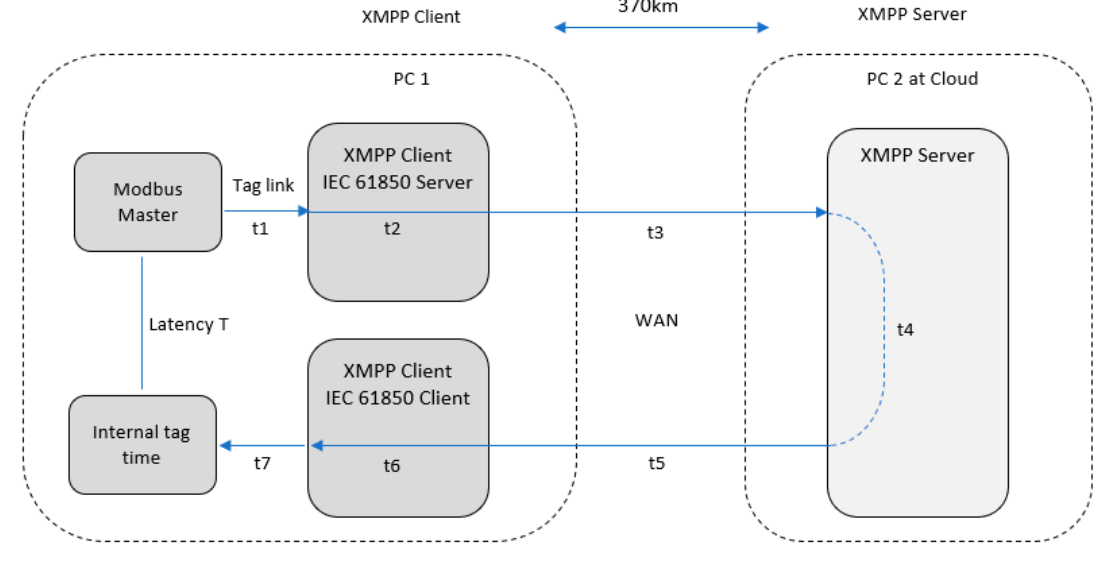
Figure 8. Total latency calculation. Table 4. IEC 61850 sequence of event transport values, quality and timestamps of SCADA